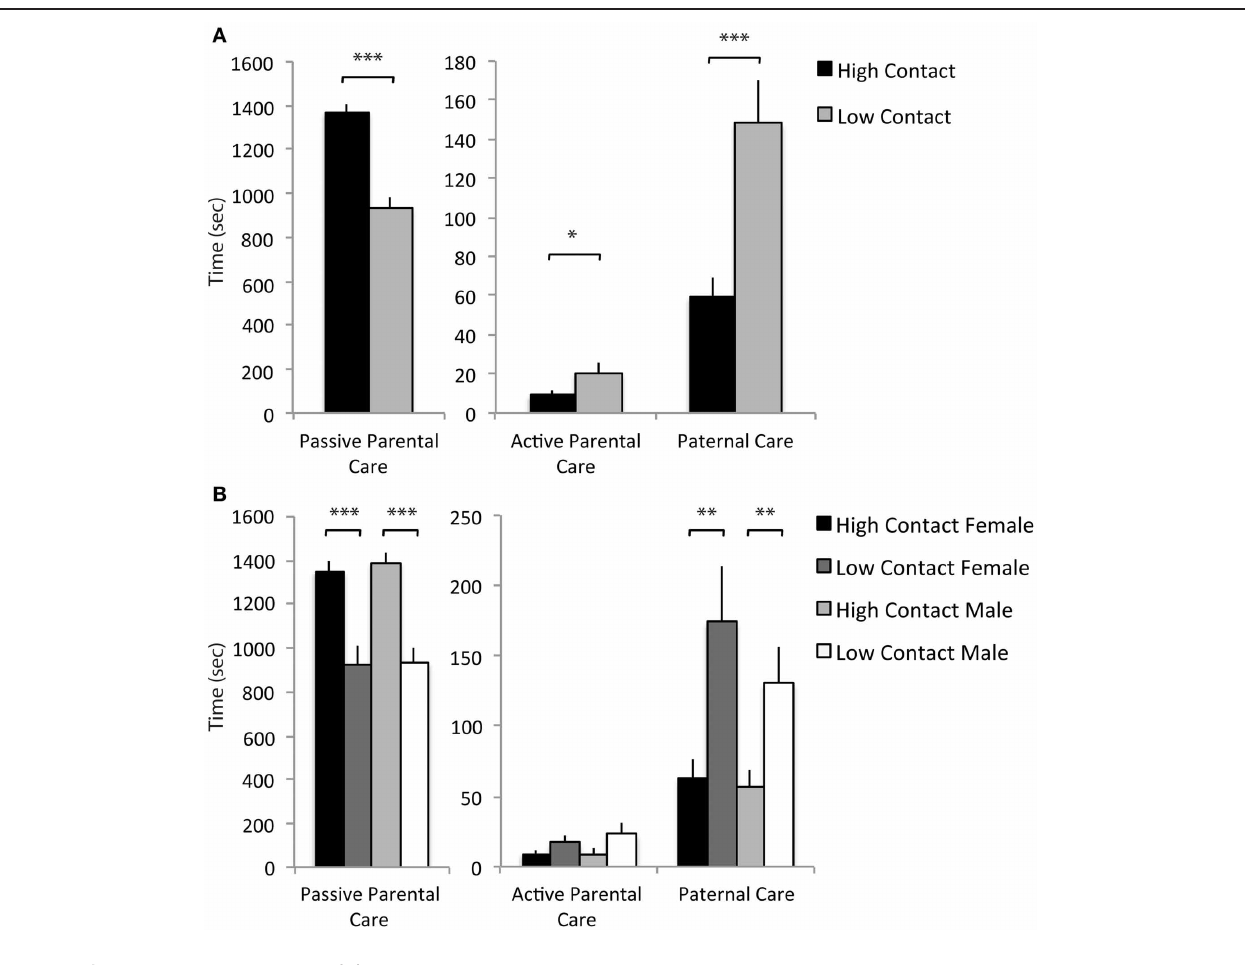
passive parental care compared to low-contact male offspring [ F ( 1 , 228 ) = 33 . 68, p < 0 . 0001] and had lower scores for paternal care [ F ( 1 , 228 ) = 7 . 18, p = 0 . 008]. The same paternal was seen in female offspring [passive parental care, F ( 1 , 228 ) = 22 . 52, p < 0 . 0001; paternal